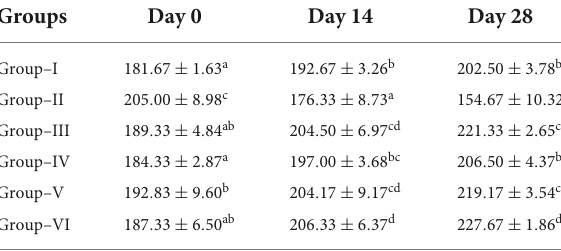
TABLE 2 Effect of ethanoic extract of Solanum torvum fruits on body weight of streptozotocin (STZ)-induced diabetic rats.